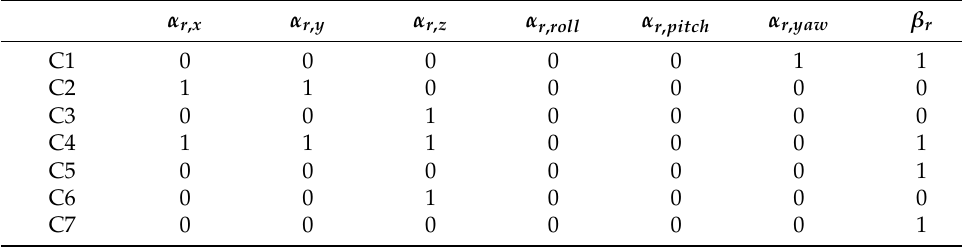
Table 1. The predefined parameters related to the left